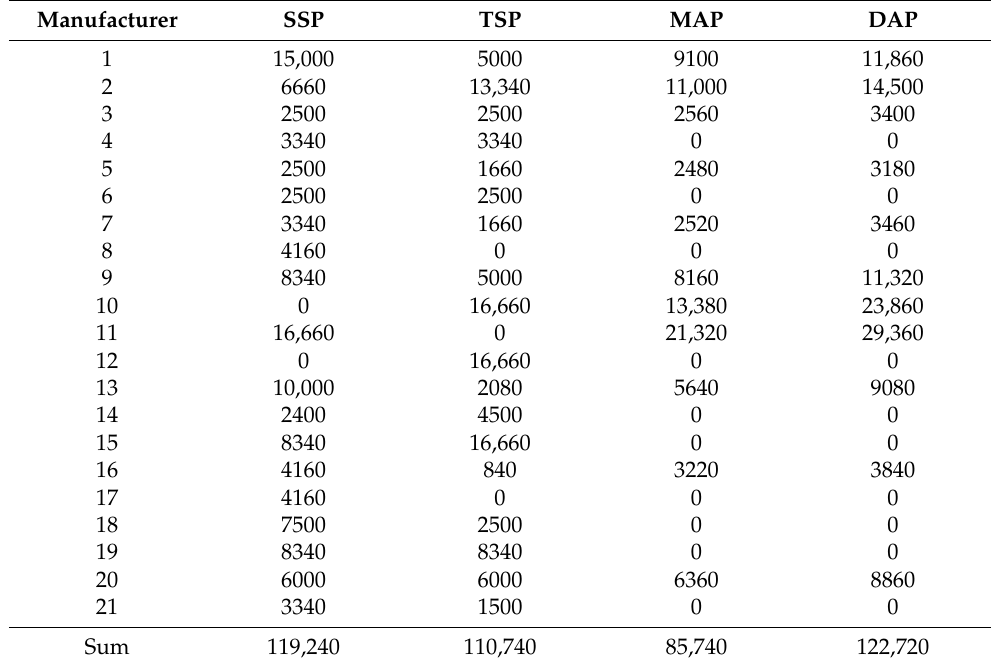
Table 5. Monthly capacity of the manufacturers for the P-fertilizer production (ton).